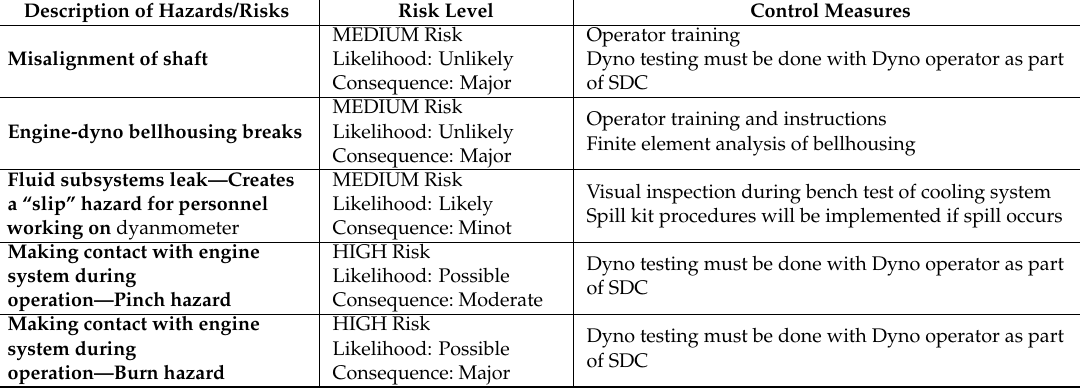
Table 4. Example of HARA Analysis of dynamometer testing of engine system.